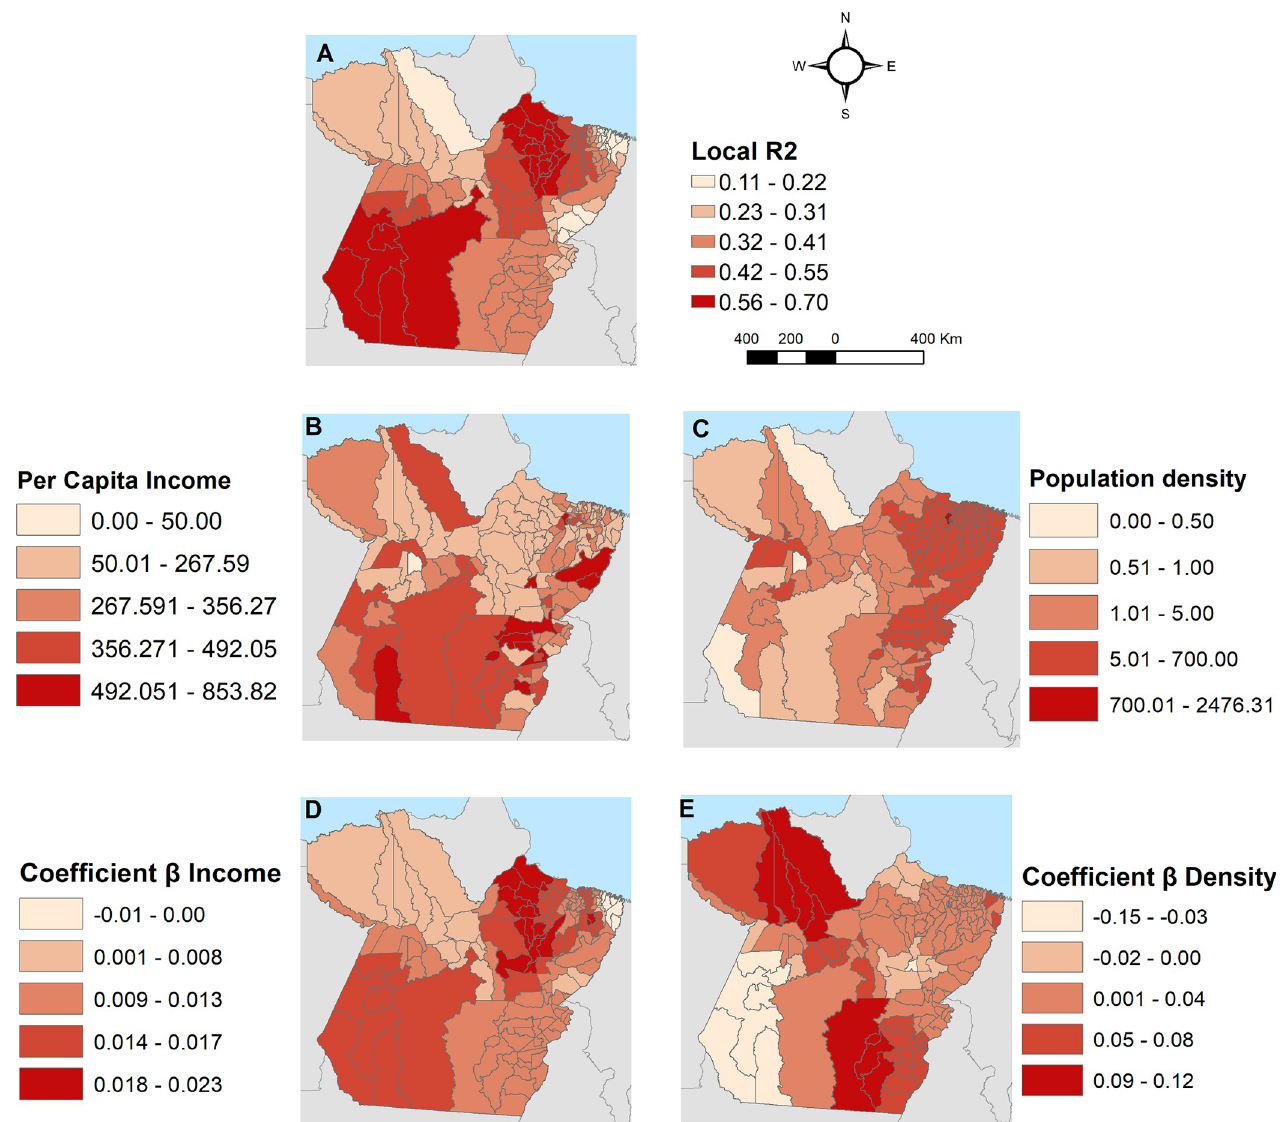
Fig 4. Spatial analysis by geographically weighted regression (GWR) of the social determinants of health and their relationship with AIDS mortality in the state of Para ´ , Brazil from 2007 to 2018. A) Local R 2 , B) Spatial distribution of per capita income, C) Spatial distribution of population density, D) β coefficients for per capita income, and E) for population density. Source: